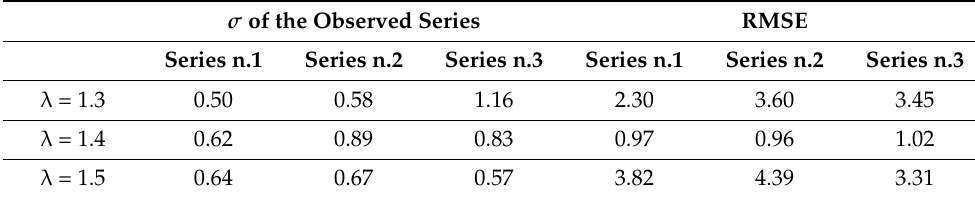
Table 4. Prediction quality evaluation, through RMSE, at each λ value.